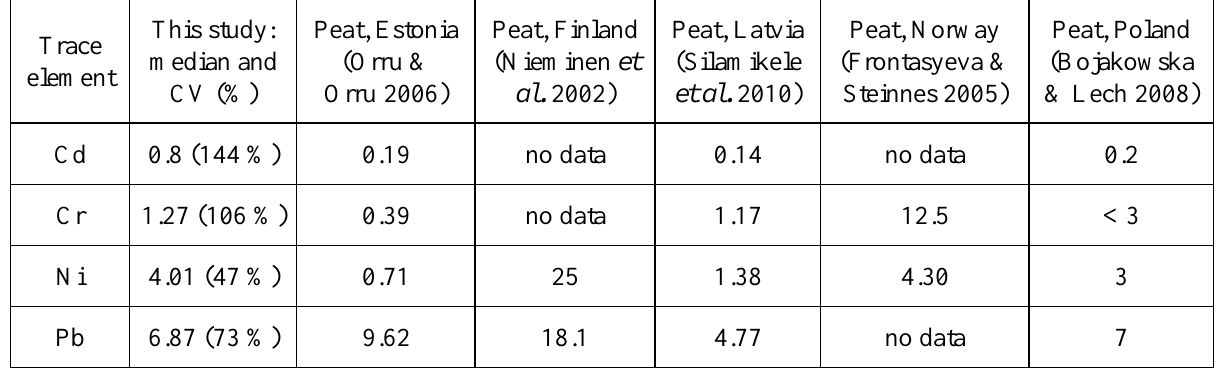
Table 1. The average concentrations of trace elements (ppm) and coefficients of variation (%) in samples from peatlands on Bolshoy Solovetsky Island and other countries in